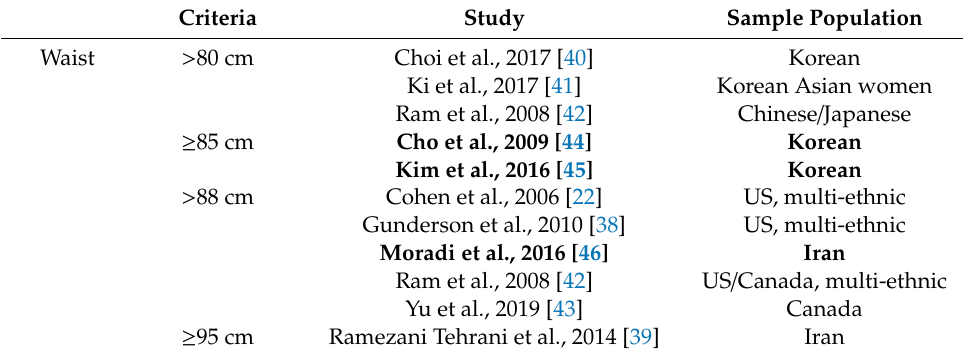
Table 5. Di ff erent criteria for waist circumference that were used to diagnose metabolic syndrome (MetS) in the included studies in this review. Criteria Study Sample Population Waist > 80 cm Choi et al., 2017